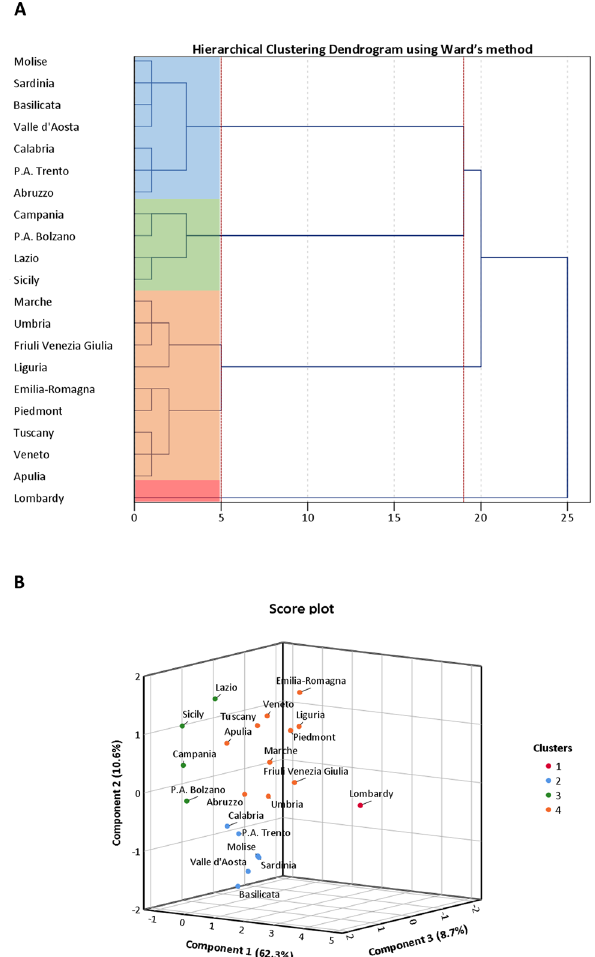
Figure 1. Clustering on Principal Components (PCs). ( A ) Dendrogram of Hierarchical Clustering based on the Ward’s criterion. The height of the branches indicates the dissimilarity between clusters. The dendrogram was partitioned (red dotted lines) to maximize the distance between nodes. Cluster solution is indicated by four colored panels. ( B ) Three-dimensional Score plot illustrating how clusters were distributed on PCs. The number of clusters to be retained was set according to the dendrogram and cluster solution was consolidated by K-means